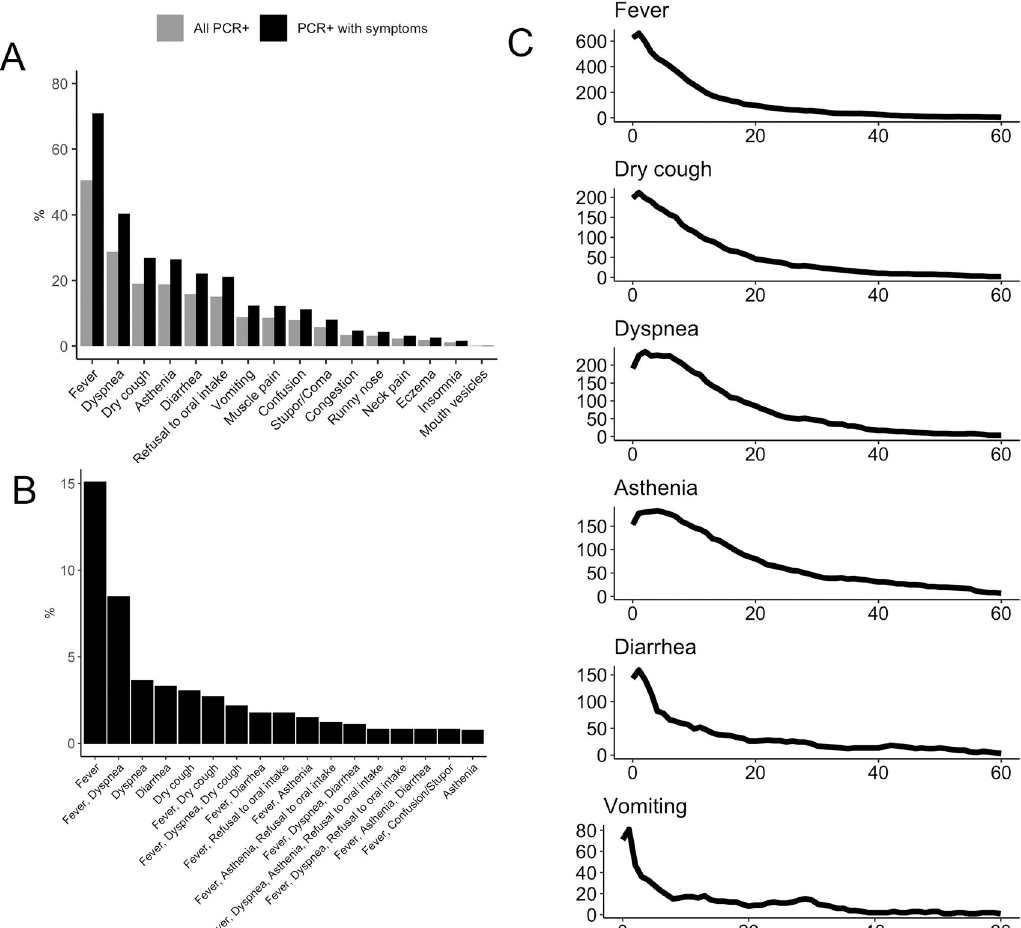
Fig 1. Clinical features of the cohort. Legend: Panel A- Percentage of patients presenting a symptom. Lights bars indicate percentage of symptoms in all positive PCR individuals. Dark bars indicate percentage of symptoms in positive PCR individuals who show symptoms. Panel B- Most frequent clinical phenotypes among PCR positive patients. Percentage of the most frequent clinical phenotypes in PCR positive patients with symptoms. Panel C- Clinical courses of six of the most frequent symptoms from the onset of the disease. Duration (in days) of the most frequent symptoms (Date at onset is defined for each resident as the day the first symptom was present).